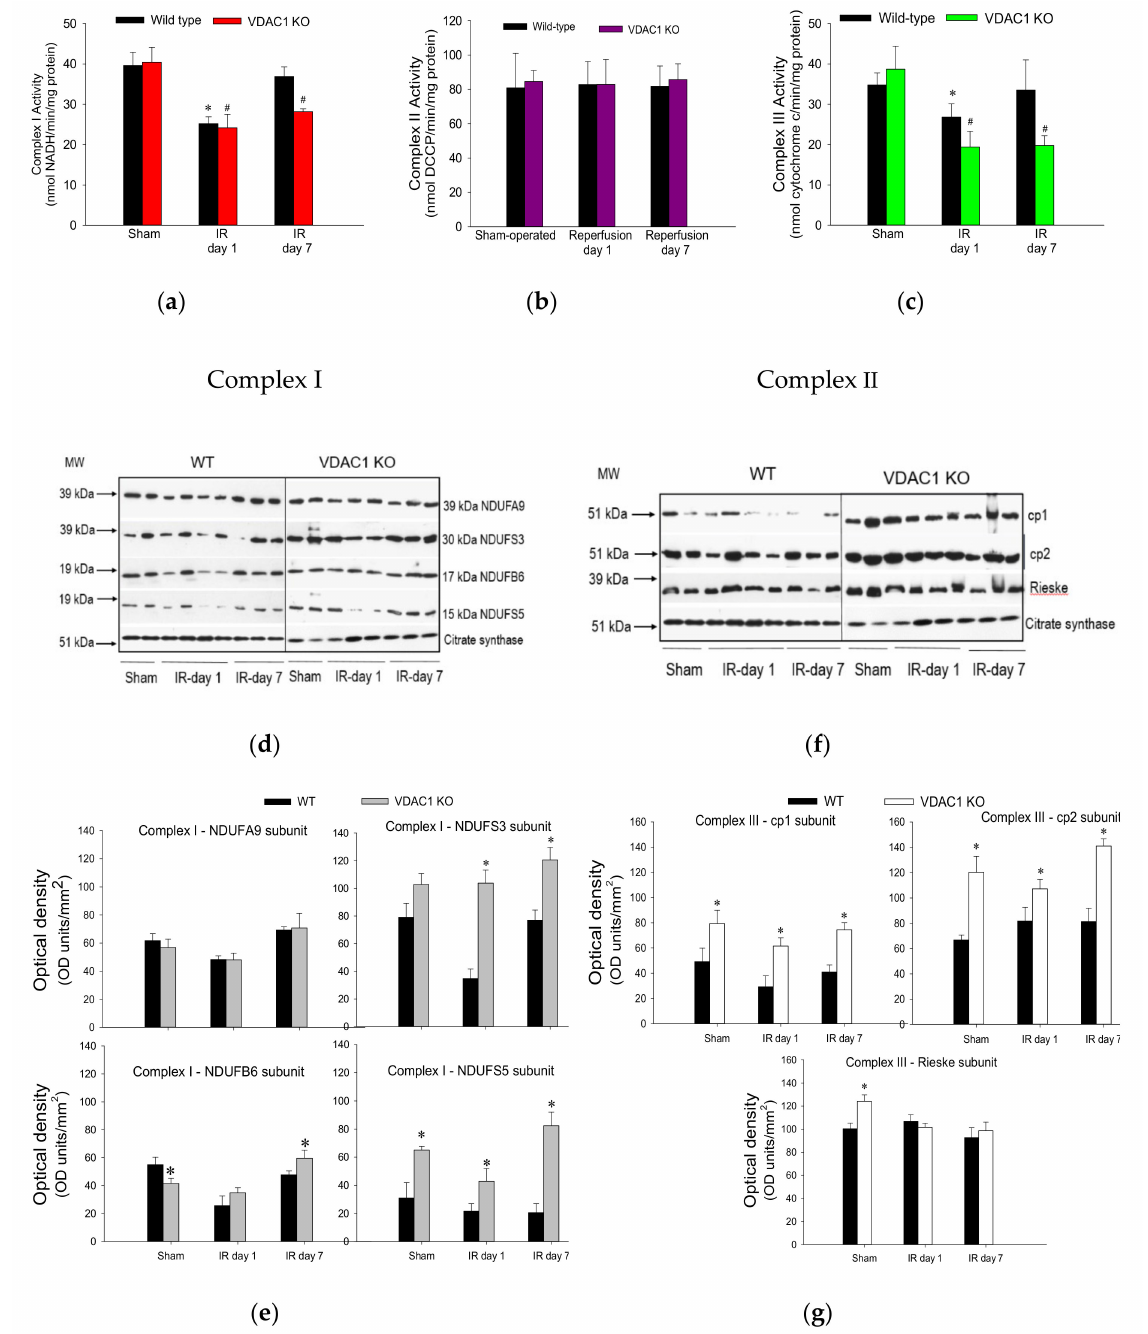
Figure 7. Deletion of VDAC1 impairs recovery of activities of complexes I and III of the electron transport chain in the renal cortex after ischemia-induced acute kidney injury. Activities of NADH:Ubiquinone Oxidoreductase (complex I) ( a ), Succinate:Ubiquinone Oxidoreductase (complex II) ( b ), and Ubiquinol:Cytochrome c Oxidoreductase ( c ) in mitochondria isolated from renal cortices of wild type (WT) and VDAC1-deficient (VDAC1 KO) mice on days 1 and 7 after bilateral renal ischemia (35 min). Protein levels ( d ) and densitometric analysis of immunoblots ( e ) of subunits NDUFA9, NDUFS3, NDUFB6, and NDUFS5 of NADH:ubiquinone oxidoreductase at di ff erent time points of recovery after bilateral renal ischemia (35 min) in wild type (WT) and VDAC1-deficient (VDAC1 KO) mice. Protein levels ( f ) and densitometric analysis of in immunoblots ( g ) of core protein 1 (cp1), core protein 2 (cp2), and Rieske subunit of ubiquinol:cytochrome c oxidoreductase at di ff erent